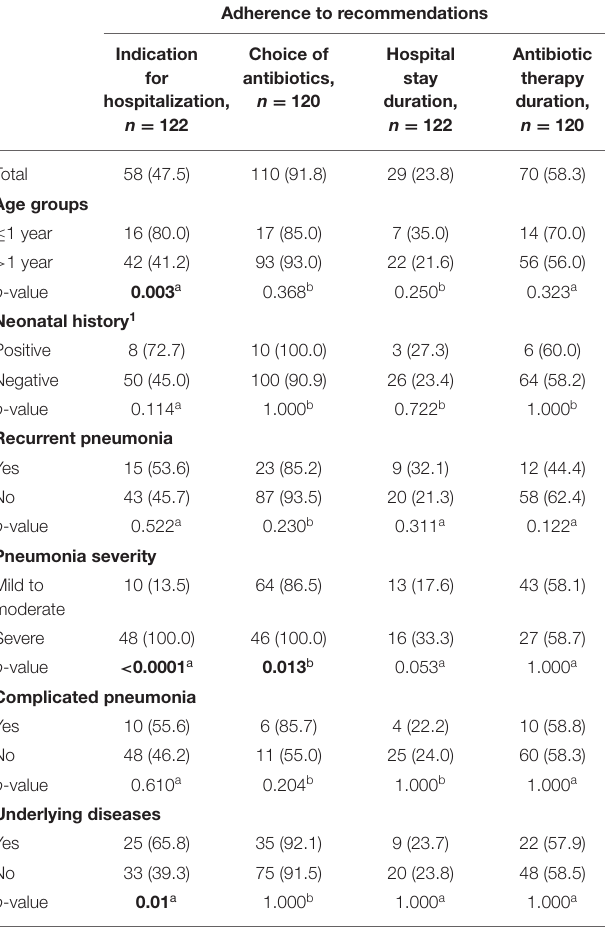
TABLE 3 | Clinical factors affecting adherence to recommendations in children hospitalized for